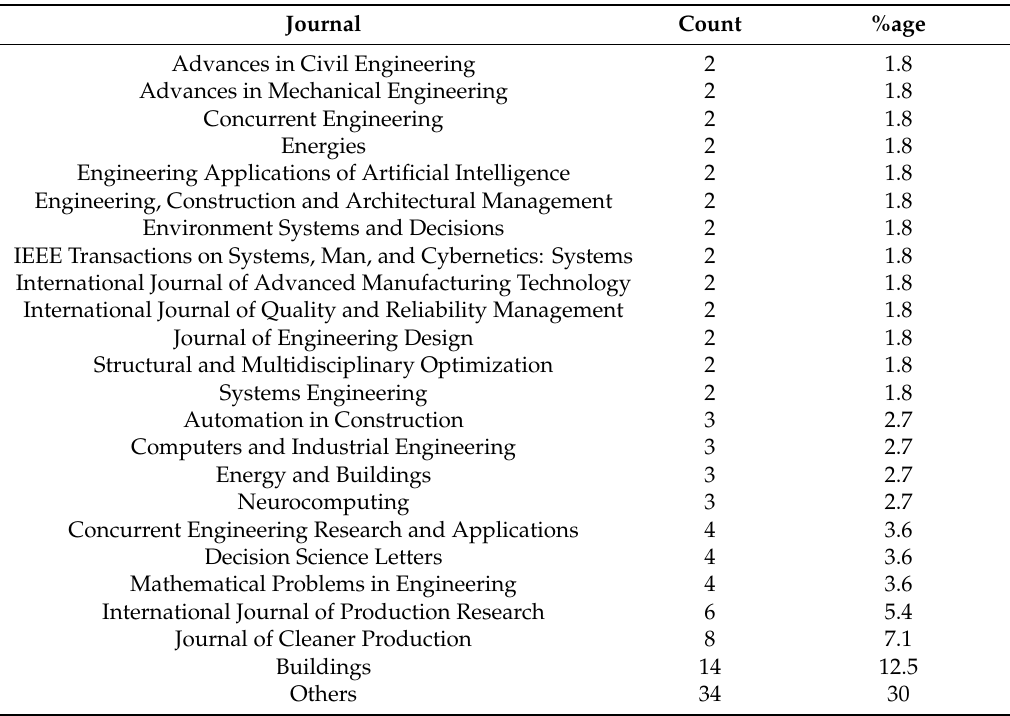
Table 2. Summary of major journal papers.